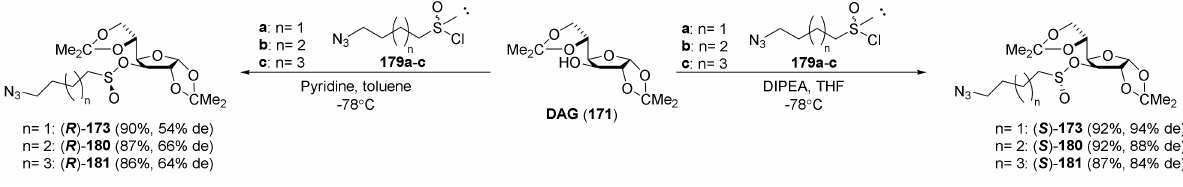
Figure 29. Enantiodivergent synthesis of ( S )- and ( R )-sulfinate esters 173 , 180 , and 181 using the